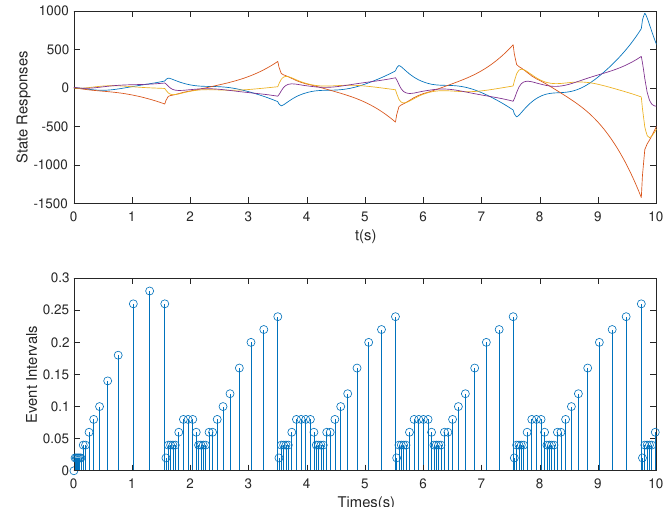
Figure 10. State responses and event intervals with DoS attacks ( p = 1.5 s) for